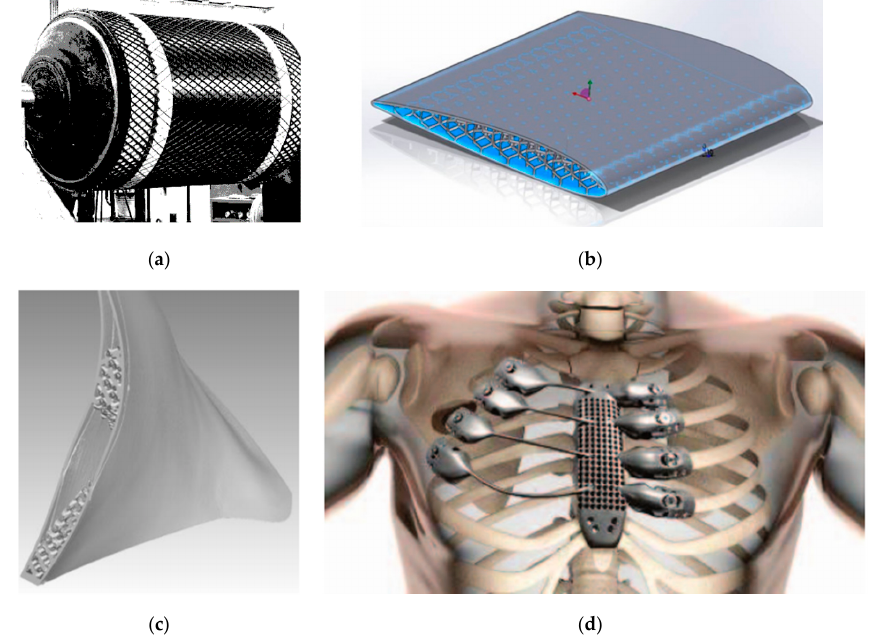
Figure 9. Applications of lattice structures: ( a ) winding of helical rib [63]; ( b ) aerial vehicle wing structure [56]; ( c ) fan blade [57]; ( d ) biomedical implant [7,121].